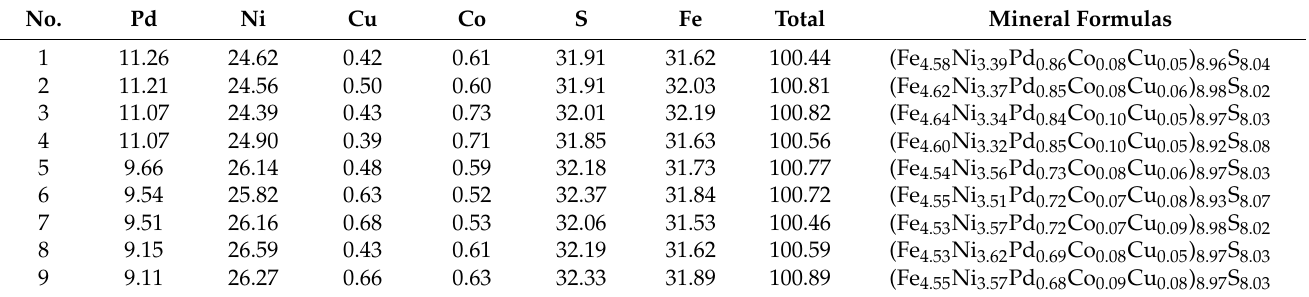
Table 3. Representative compositions of pentlandite with the highest palladium content (wt.%). No.